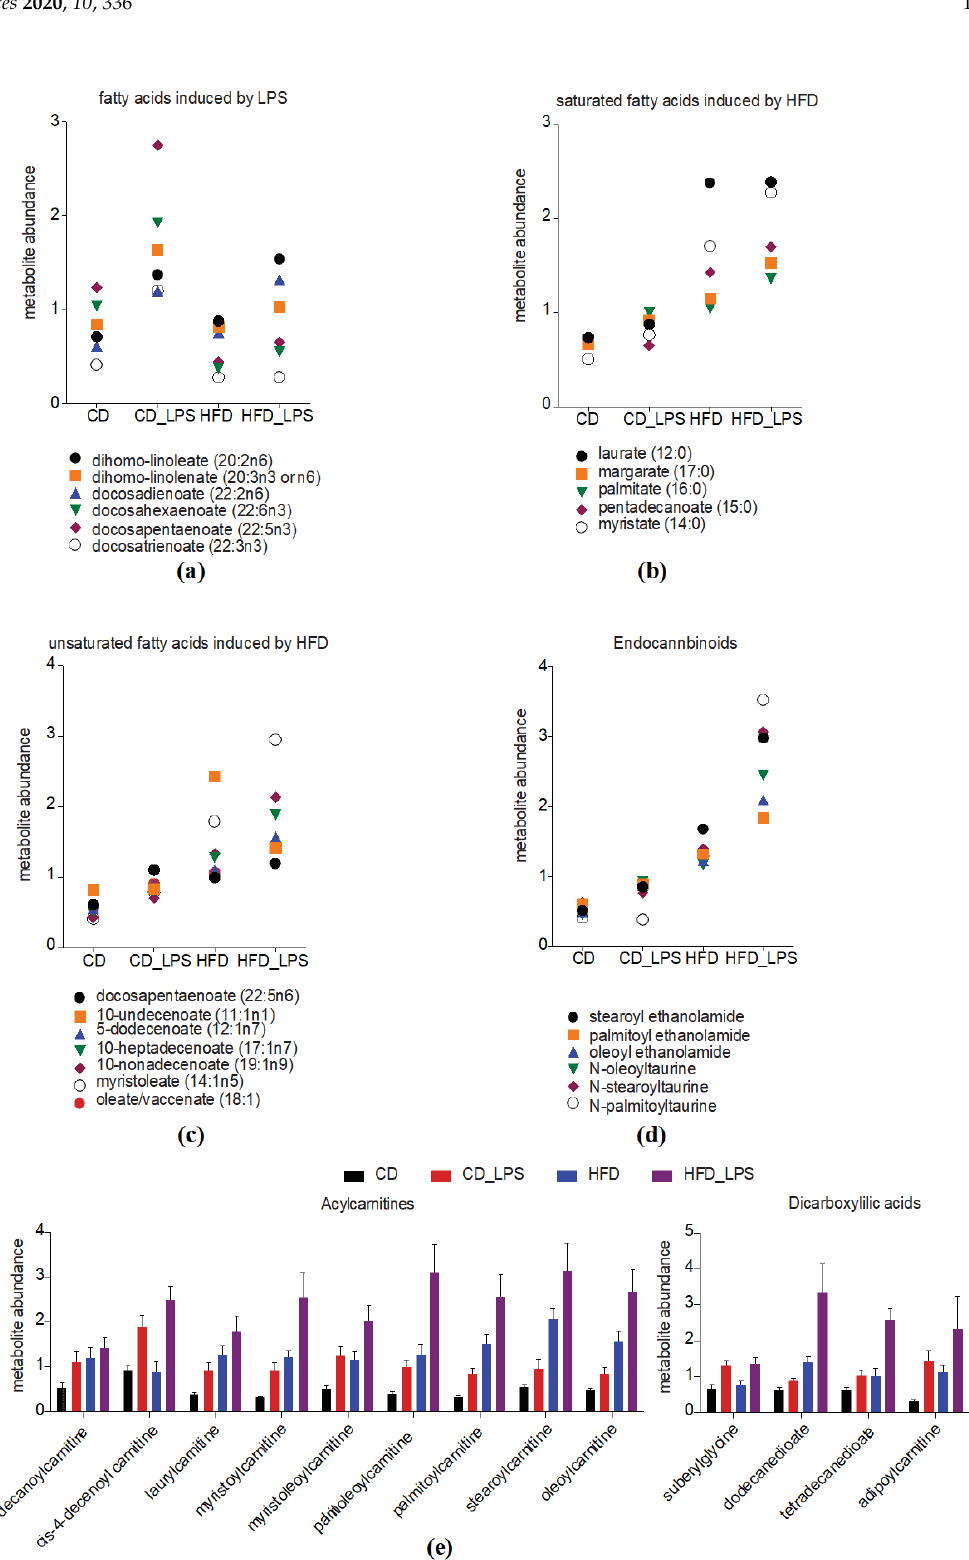
Figure 6. Synergistic effects of LPS treatment and HFD feeding on specific metabolite classes. ( a–e ) Abundances of ( a ) Endocannabinoids; ( b ) LPS-upregulated fatty acids; ( c ) HFD-upregulated unsaturated fatty acids; ( d ) HFD-upregulated saturated fatty acids in the CD-, CD_LPS-, HFD- and HFD_LPS-treated groups. Means of individual metabolites are presented; ( e ) Abundances of upregulated acylcarnitines and dicarboxilic acids. Means and SEM are presented.